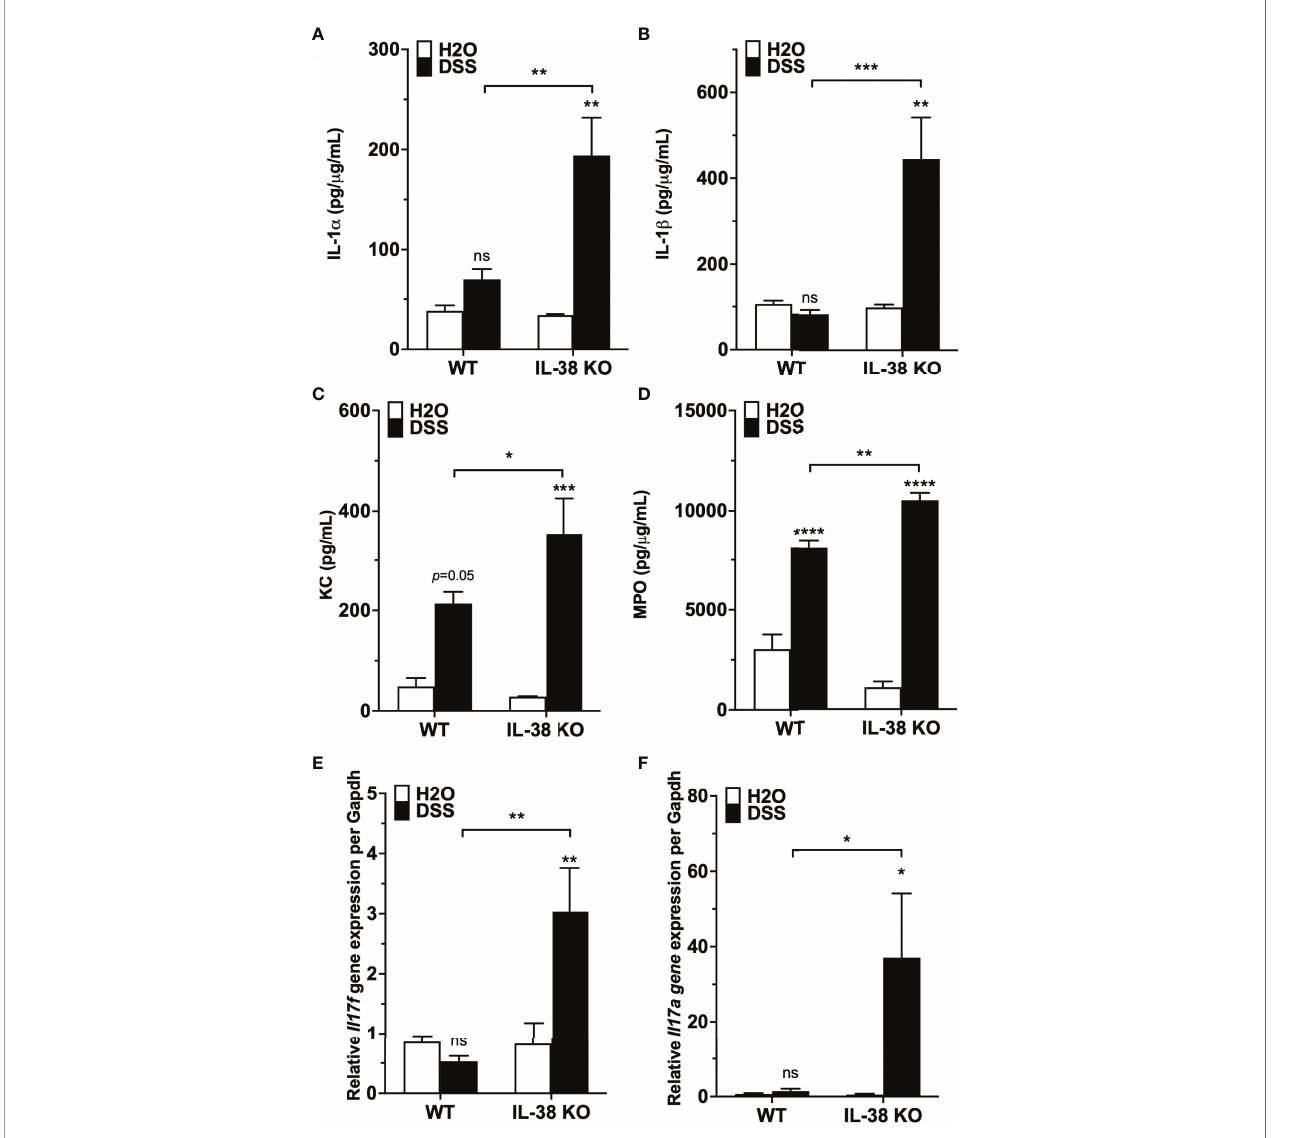
FIGURE 3 | Mice lacking IL-38 have increased expression of in fl ammatory cytokines in colitis. WT and IL-38 KO mice were subjected to H 2 O or DSS. (A, B) IL-1 a , IL-1 b protein expression in colon tissue, (C) plasma KC concentration, (D) MPO protein expression in colon tissue, (E) mRNA levels of Il17a and (F) Il17f in colonic tissue measured by qPCR, normalized to GAPDH. Data was pooled from 2-3 separate experiments. The data represents the mean ± SEM, *P < 0.05, **P < 0.01, ***P < 0.001, ****P < 0.0001 by two-way ANOVA with Fisher ’ s multiple comparison. IL-38 KO: IL-38 de fi cient. ns, not signi fi